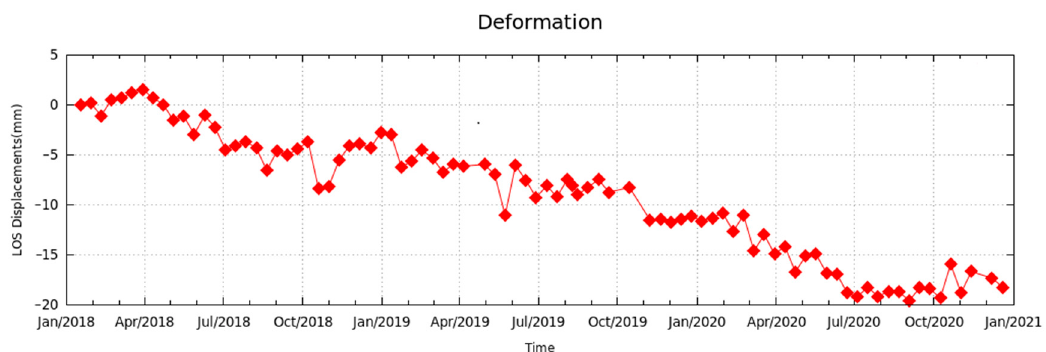
Figure 12. Deformation of point P2 during the monitoring period.